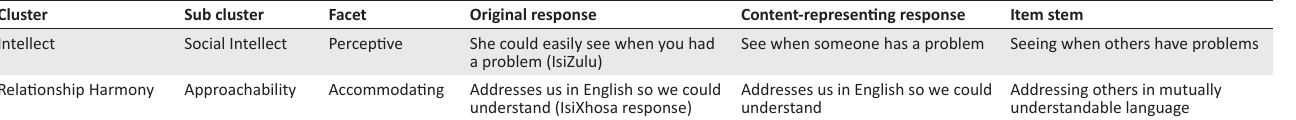
TABLE 2: Developing item